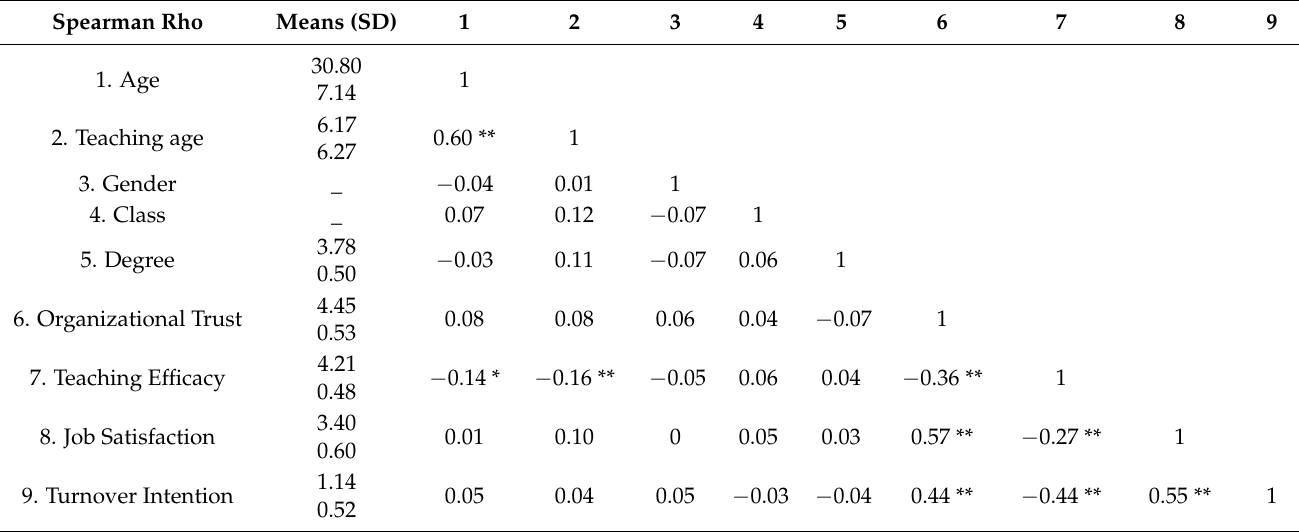
Table 1. The inter-correlations of all the studied